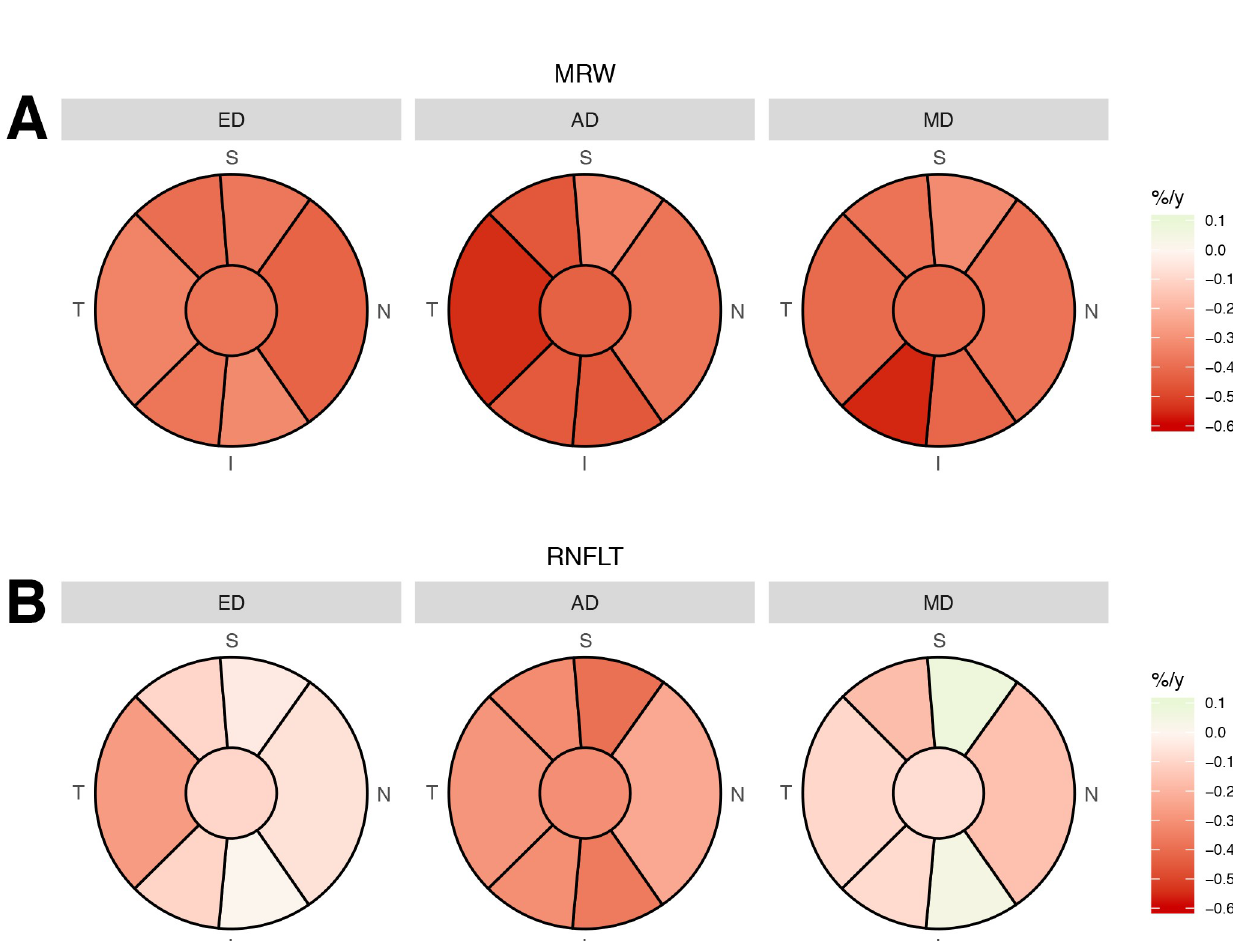
Fig 6. Graphs showing the sectorial age-related percentage decay (%/y) of (A) mean Bruch’s membrane opening minimum rim width (MRW) and (B) peripapillary retinal nerve fiber layer thickness (RNFLT) globally (central circle) and in 6 sectors . Mean decay in each sector is color-coded according to the scale in the legend. ED: European Descent; AD: African Descent; MD: Mixed Descent.